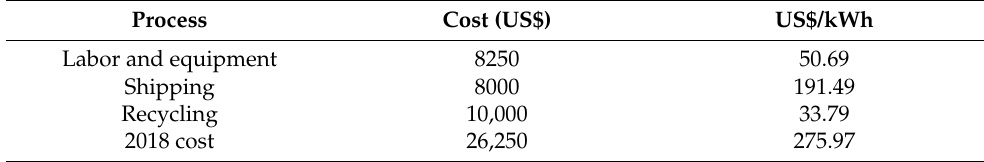
Table 8. Costs of lithium-ion battery decommissioning in 2018. Source: [39].